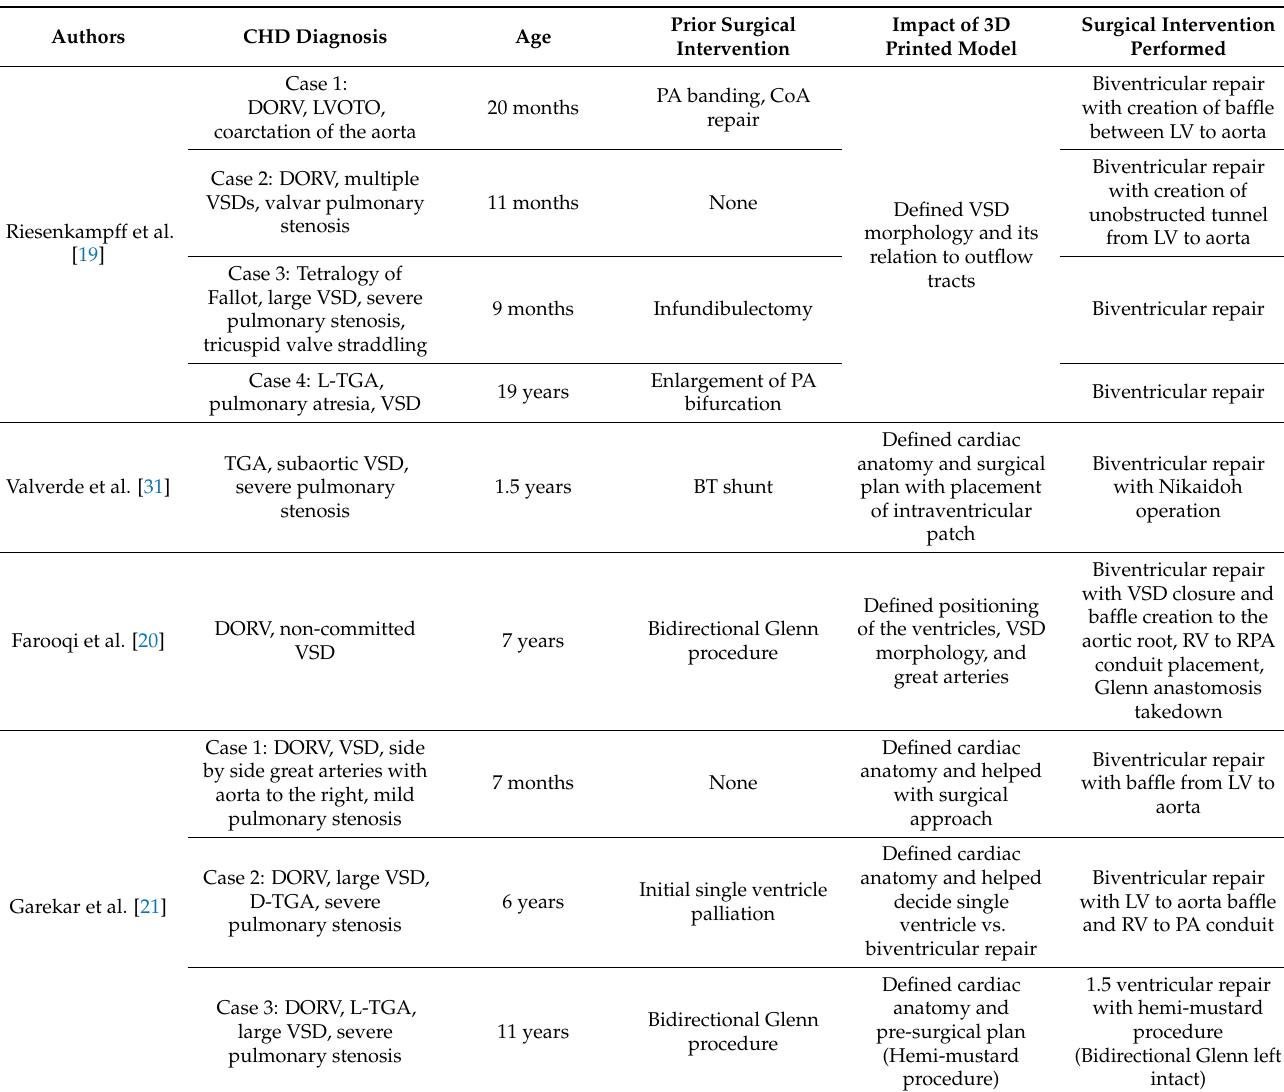
Table 1. Biventricular repair using 3D-printed cardiac models for complex cardiac